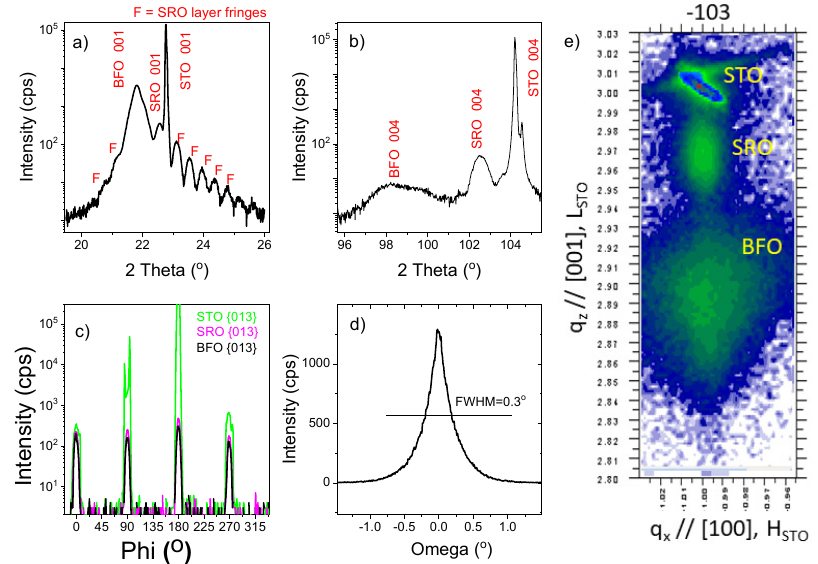
Figure 1. Results obtained by XRD measurements: ( a , b ) two representative regions of the 2 θ - ω scan; ( c ) azimuth scans on the {103} inclined crystal planes of the films and substrate; ( d ) out-of-plane rocking curve obtained on 002 BFO; ( e ) reciprocal space mapping in the vicinity of the 103 STO node. Pseudocubic indexing for BFO and